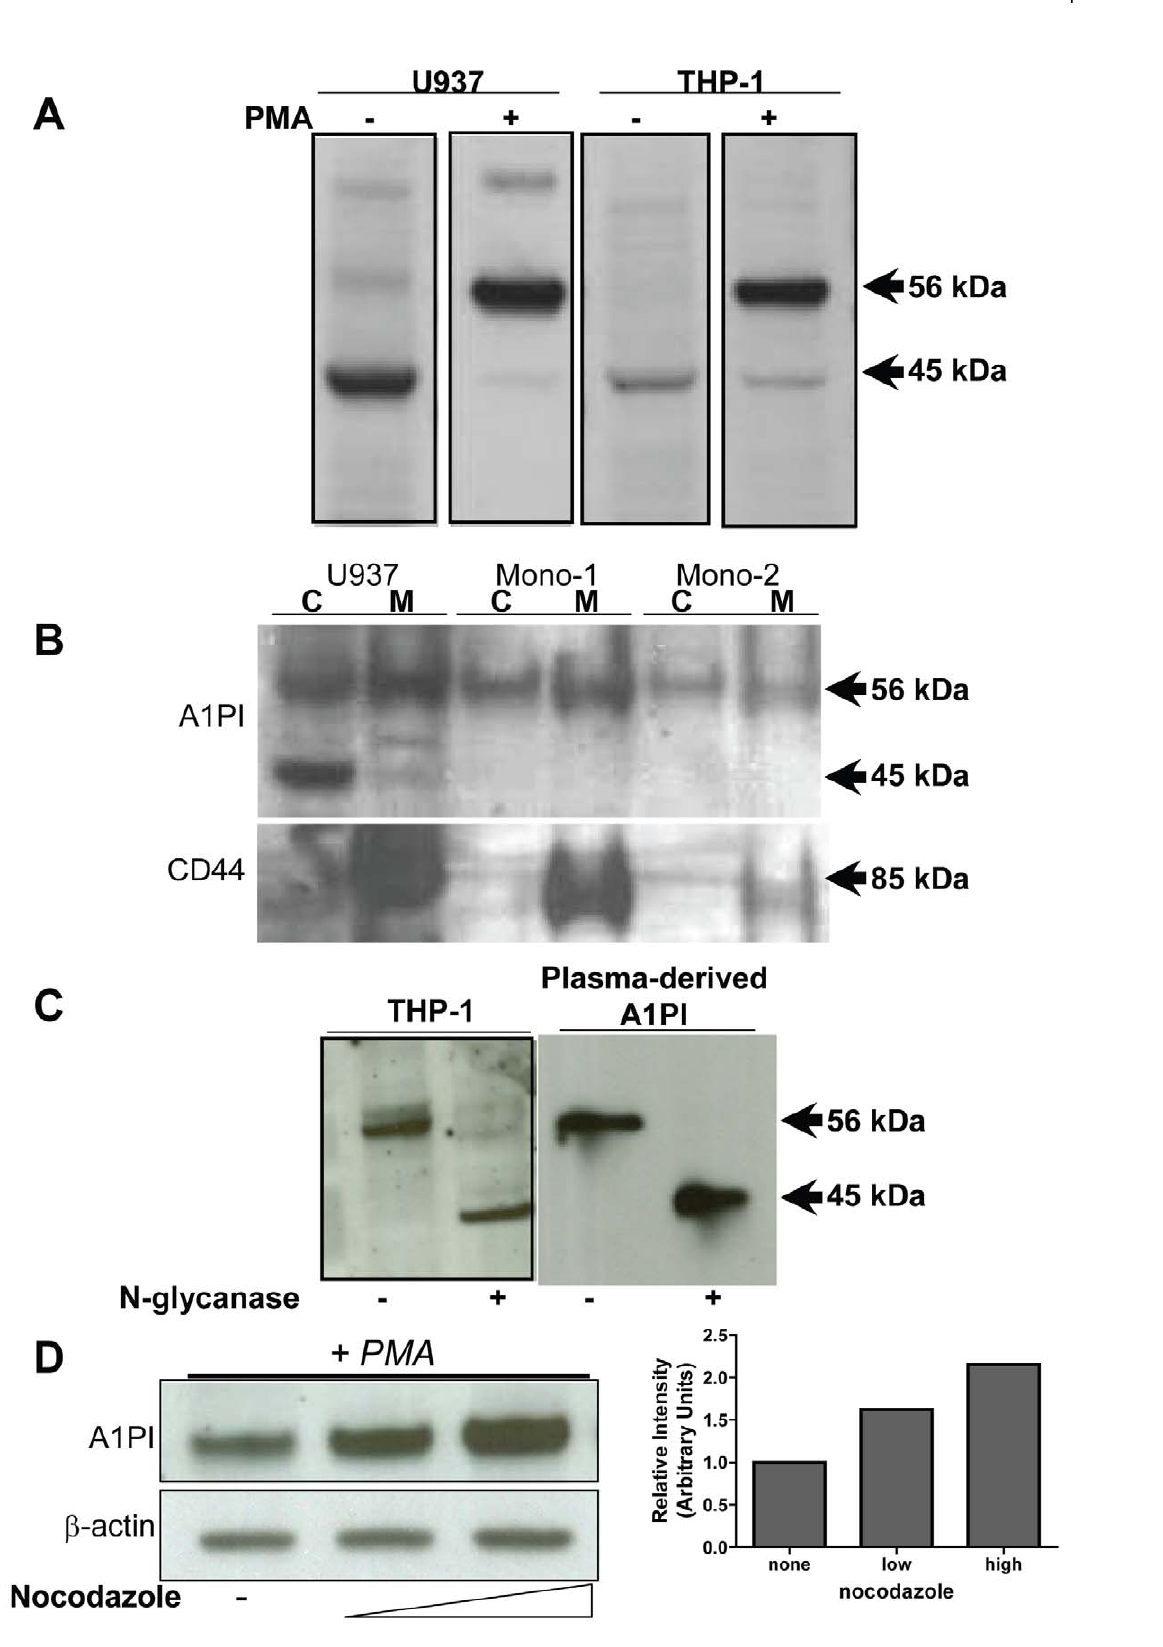
Figure 4. Cytosolic Monocyte-Expressed A1PI is Glycosylated. A) Immunoblot detection of A1PI in whole cell extracts of U937 and THP-1 monocytes with and without PMA stimulation. B) U937 cells or primary elutriated monocytes of two healthy donors (Mono-1, Mono-2) were lysed with hypotonic buffer. Cytosol (C) and membrane (M) fractions were analyzed by immunoblot for A1PI and the membrane associated protein CD44.